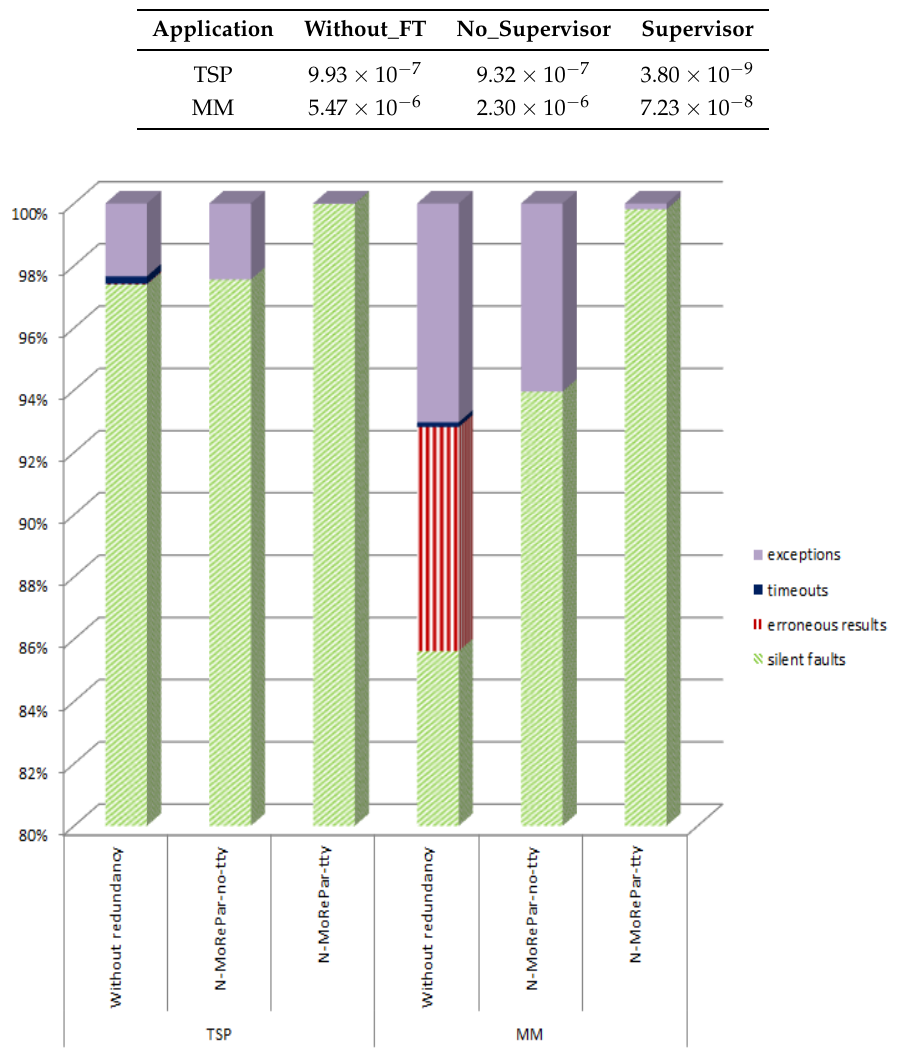
Table 7. Failure rates per hour at 35,000 feet for 4MR-8PaR applications implemented on the MPPA.